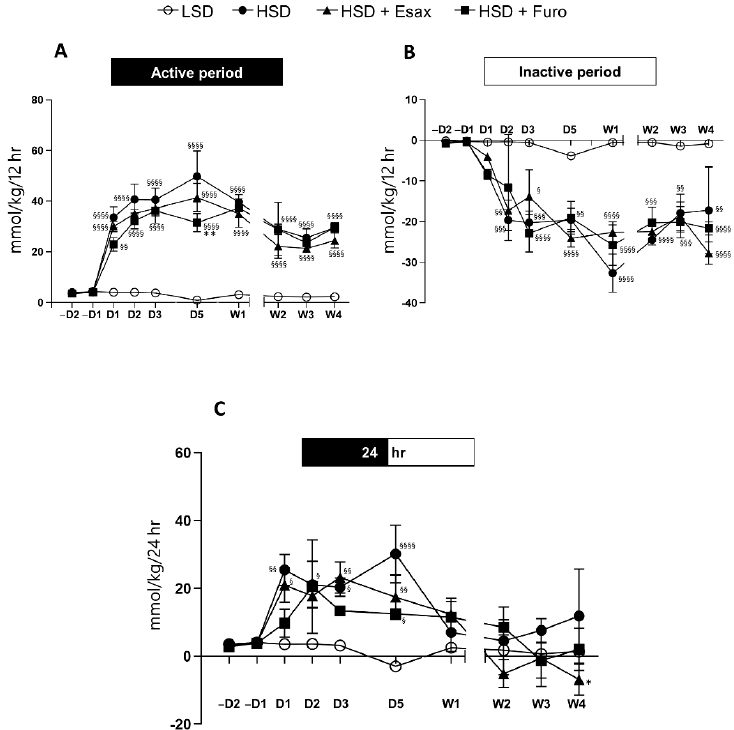
Figure 4. Time-dependent sodium balance. Calculated sodium balance in the ( A ) active and ( B ) inactive periods, and ( C ) at 24 h. § p < 0.05, §§ p < 0.01, §§§ p < 0.001 §§§§ p < 0.0001 vs. LSD; * p < 0.05, ** p < 0.01 vs. HSD.